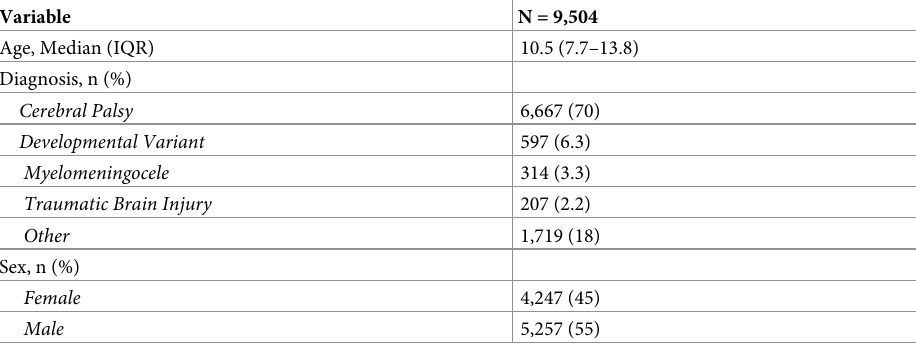
Table 1. Age, sex, and